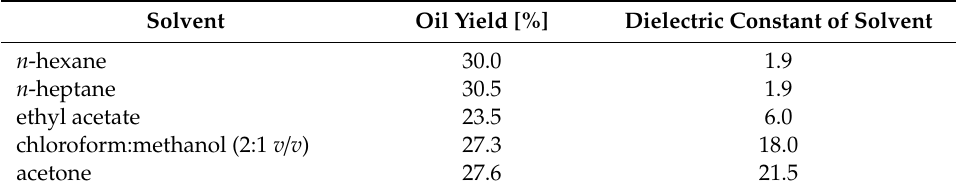
Table 1. The yield of plum seed